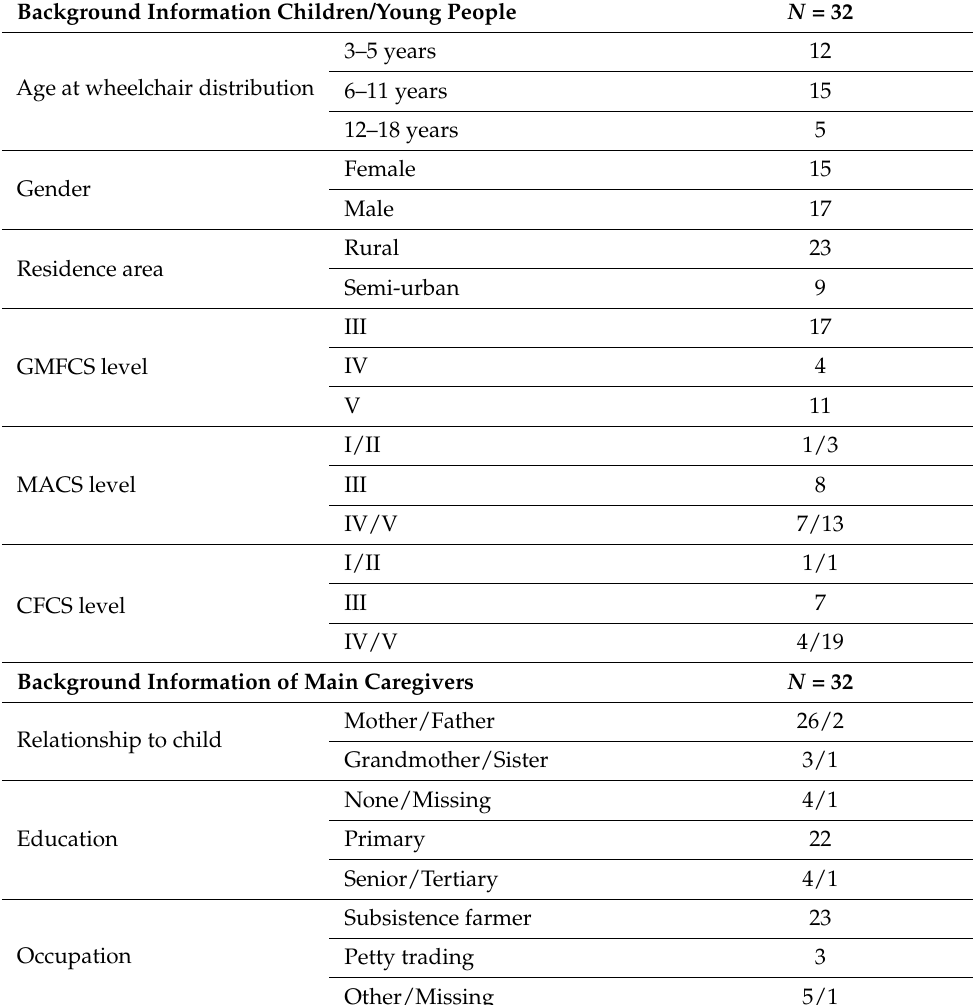
Table 1. Background information for the participants and their main